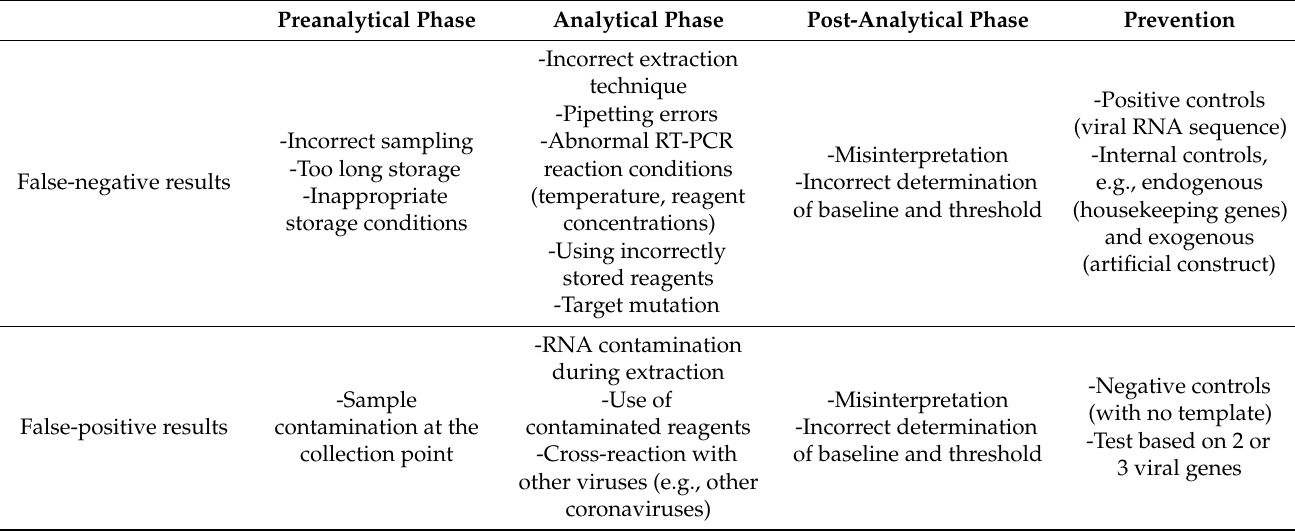
Table 1. Comparison of diagnostic errors, along with their effects and countermeasures